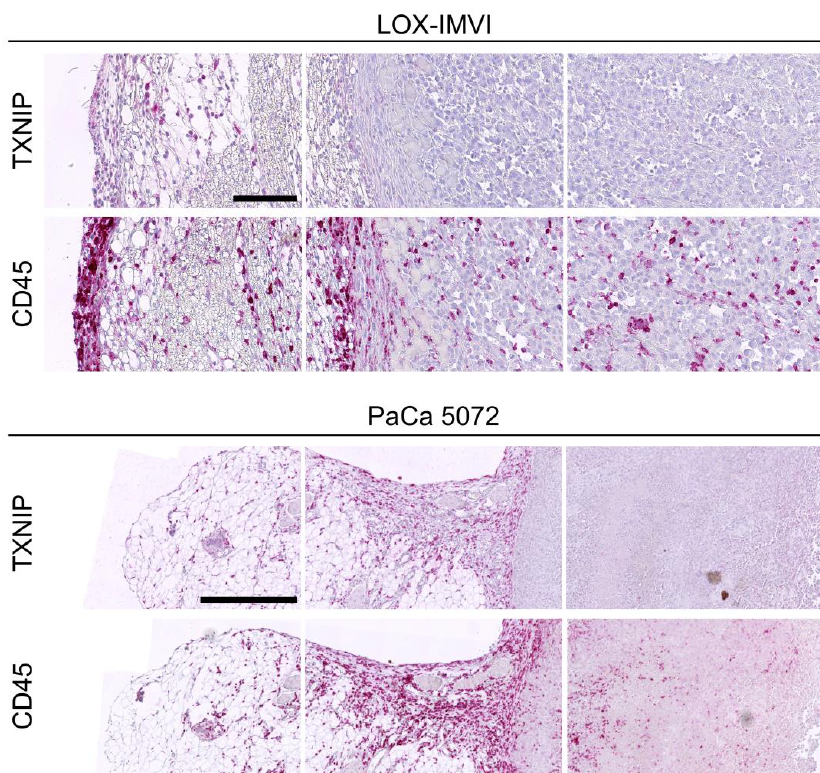
Figure 6. Downregulation of thioredoxin interacting protein (TXNIP) in intra- and peri-tumoral leukocytes. Scale bar: LOX-IMVI = 100 µm, PaCa 5072 = 500 µm. leukocytes. Scale bar: LOX-IMVI = 100 µ m, PaCa 5072 = 500 µ